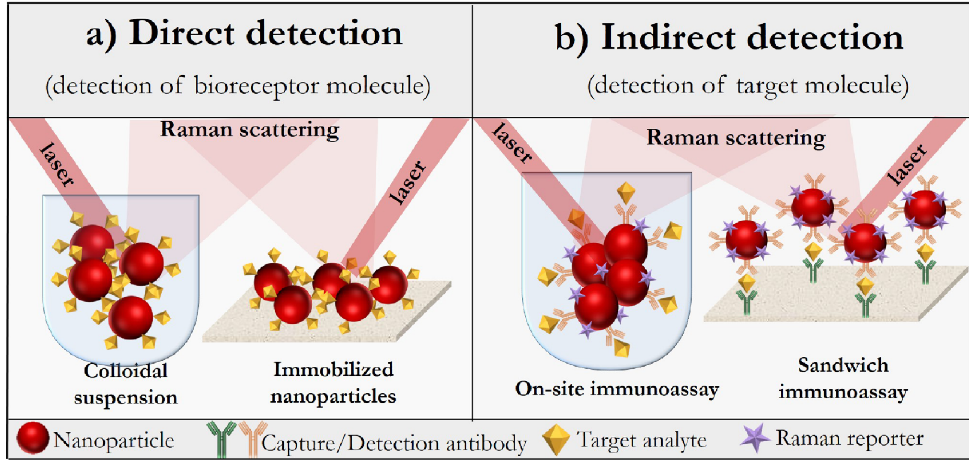
Figure 3. Schematic representation of the direct ( a ) and indirect ( b ) approaches for SERS-based de- tection.